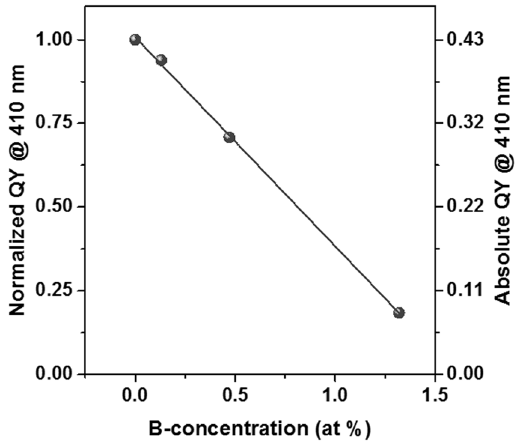
Figure 4. Luminescence Quantum Yield of B-incorporating Si NCs. The ratio of emitted photons (at PL peak) and absorbed photons (410 nm excitation) of H 2 -passivated, 4.5 nm Si NC samples decreases almost linearly with increasing B-concentration. The solid line is a linear fit with a slope of approximately − 0.6, i.e., for NCs grown from SRO:B with 1 at% the QY is quenched by 60% relative compared to an intrinsic